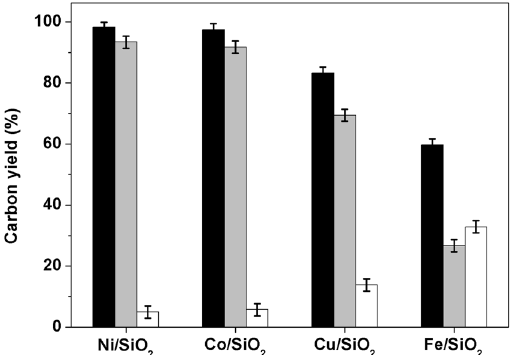
Figure 5. Carbon yields of compound 5 (gray bars), C 9 -C 17 cycloalkanes (white bars) and cycloalkanes ( i.e . the sum of compound 5 and C 9 -C 17 cycloalkanes) (black bars), from the solvent-free HDO of compound 4 over the SiO 2 loaded non-noble metal catalysts. Reaction conditions: 573 K, 6 MPa H 2 ; 1.8 g catalyst, compound 4 flow rate: 0.04 mL min − 1 , hydrogen flow rate: 120 mL min − 1 .